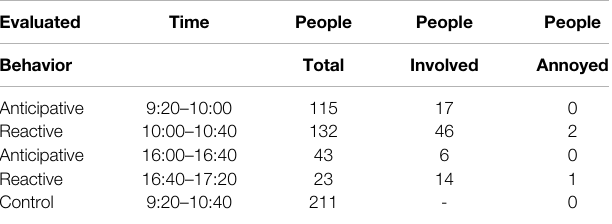
TABLE 1 | Comparison of reactive and anticipative